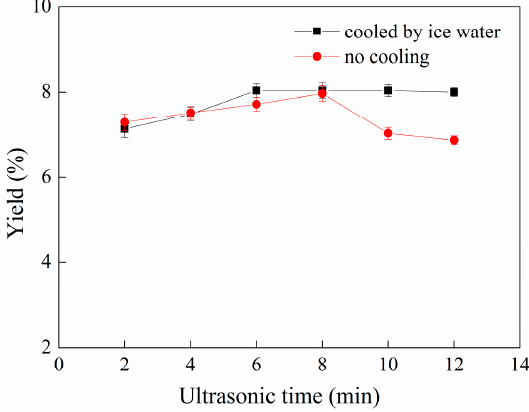
Figure 3. Relationship between ultrasonication time and yield of C-PC. Error bars indicate standard deviations of the means ( n = 3).